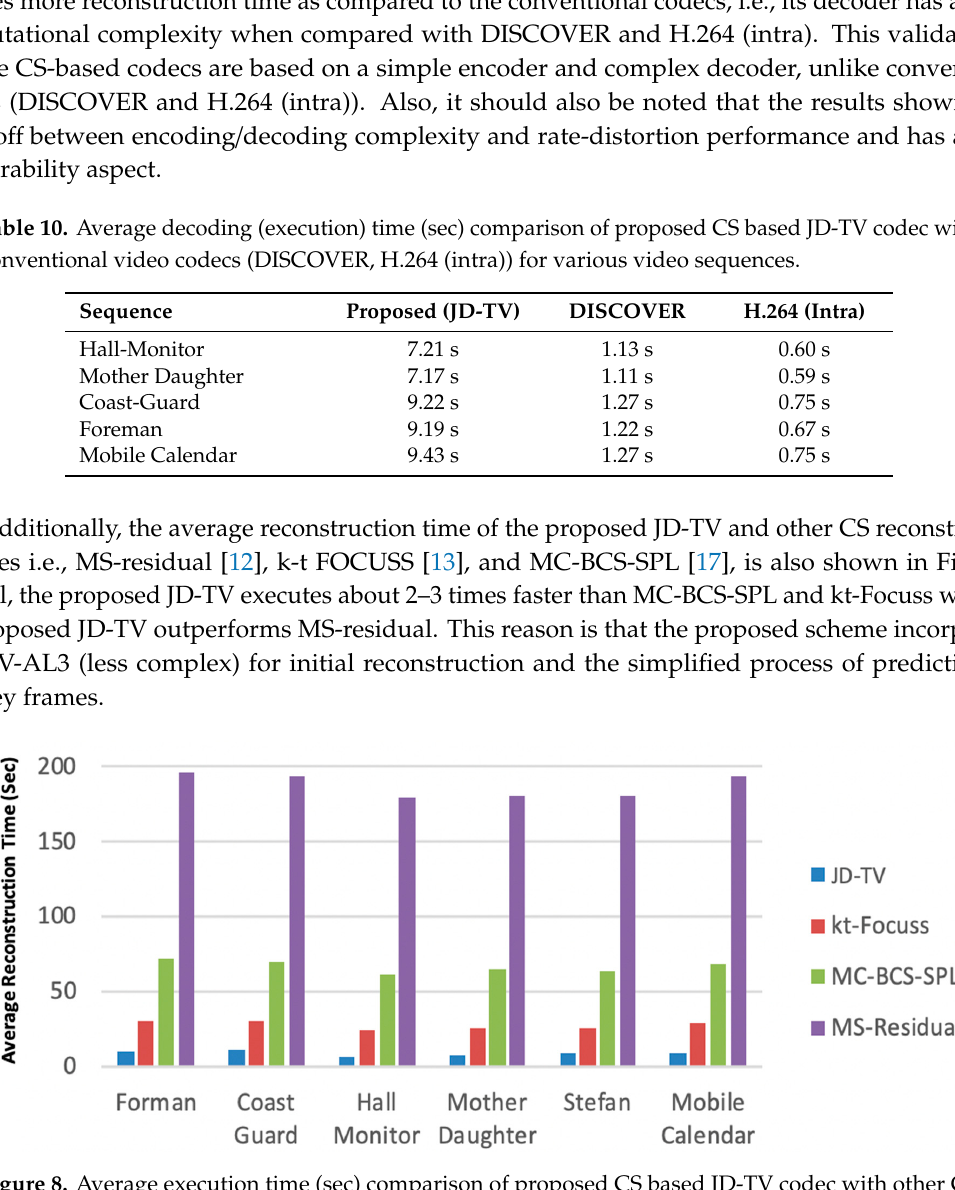
Figure 8. Average execution time (sec) comparison of proposed CS based JD-TV codec with other CS codecs for various video sequences.